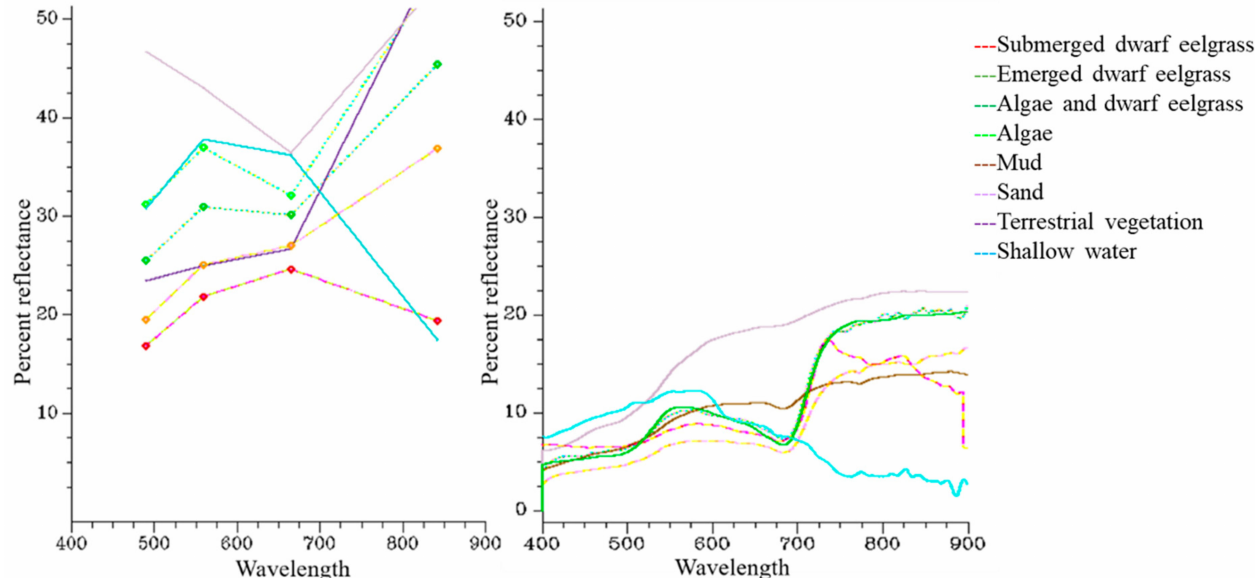
Figure 3. Spectral signatures for the eight different habitat types in the Merja Zerga lagoon: emerged Z. noltei , submerged Z. noltei , algae, mixed beds of Z. noltei and algae, sand, mud, and shallow water. Left: average spectra (n = 5) numbers degraded to the four SPOT 7 satellite image bands: 1 (blue; 450–520 nm), 2 (green; 530–590 nm), 3 (red; 625–695 nm), and 4 (NIR; 760–890 nm). Right: average spectra acquired at the spectral resolution of a JAZA0478 spectroradiometer.